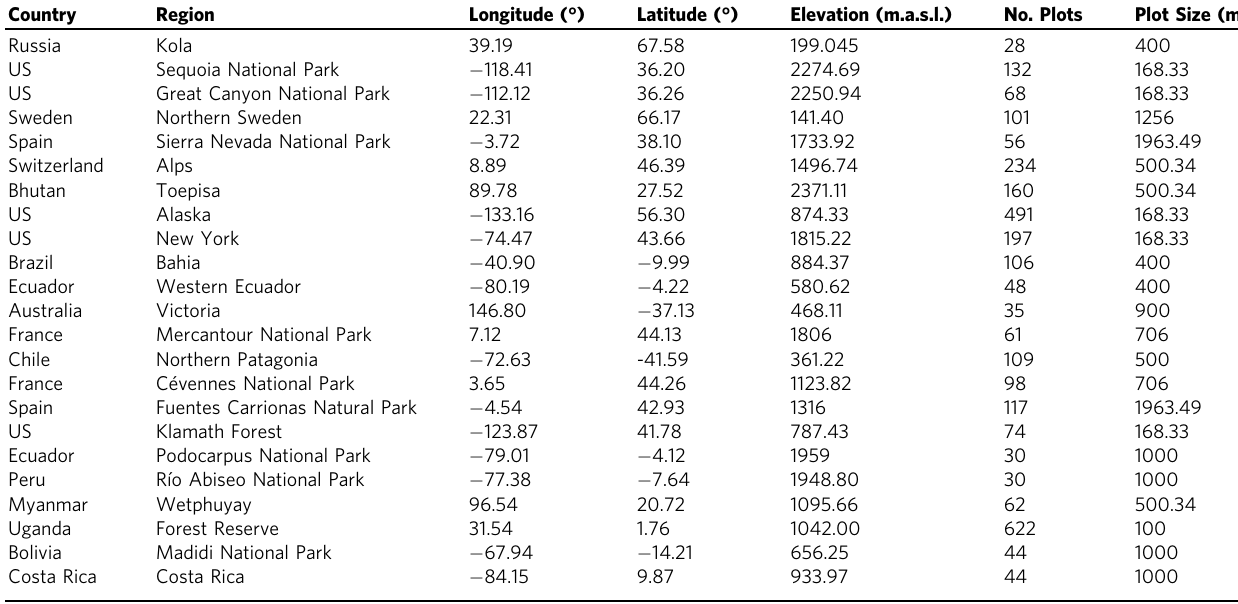
Table 1 Descriptive geographic and sampling information for each of the 23 forest